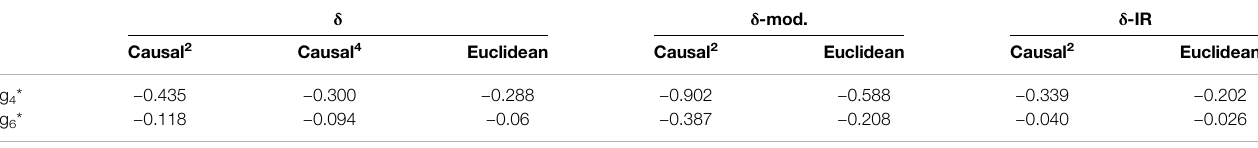
TABLE 3 | Numerical values obtained for critical points. Causal 2 corresponds to values computed using (21) and Causal 4 corresponds to the ones computed using (LABEL:c4). δ δ -mod.